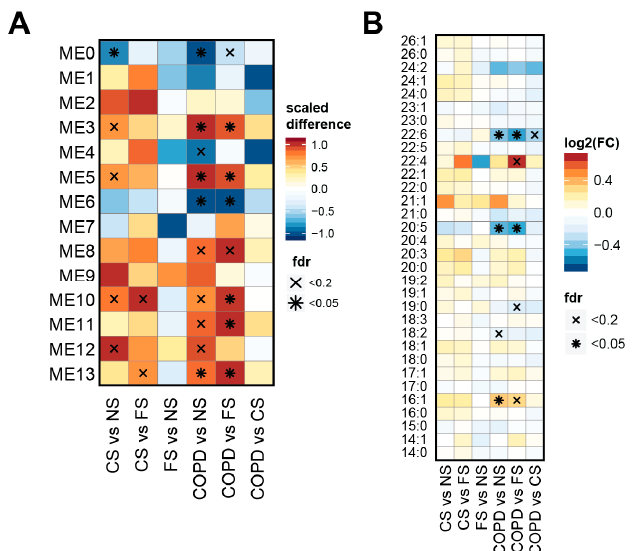
Figure 4. Lipid modules show differences among the study groups. ( A ) Association of the lipid clusters with study group comparisons. Note that this analysis is based on the module eigenlipids (MEs), which are numbered according to their respective modules; ( B ) lipids with 20:5 and 22:6 fatty acids were significantly less abundant in the COPD group. The heatmap is as in Figure 1B, but for the concentrations of the different (conjugated) fatty acids.